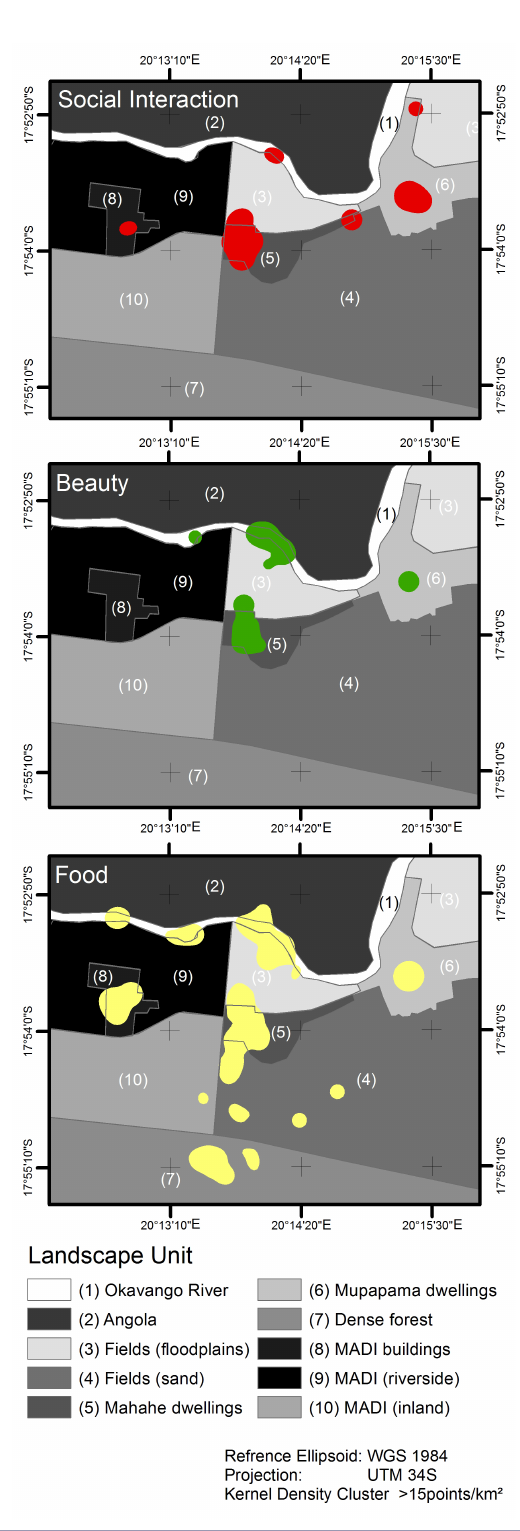
Fig. 2 . Kernel density clusters for social interaction, beauty, and food services (scale 1:100,000; cell size 50 m, search radius 300